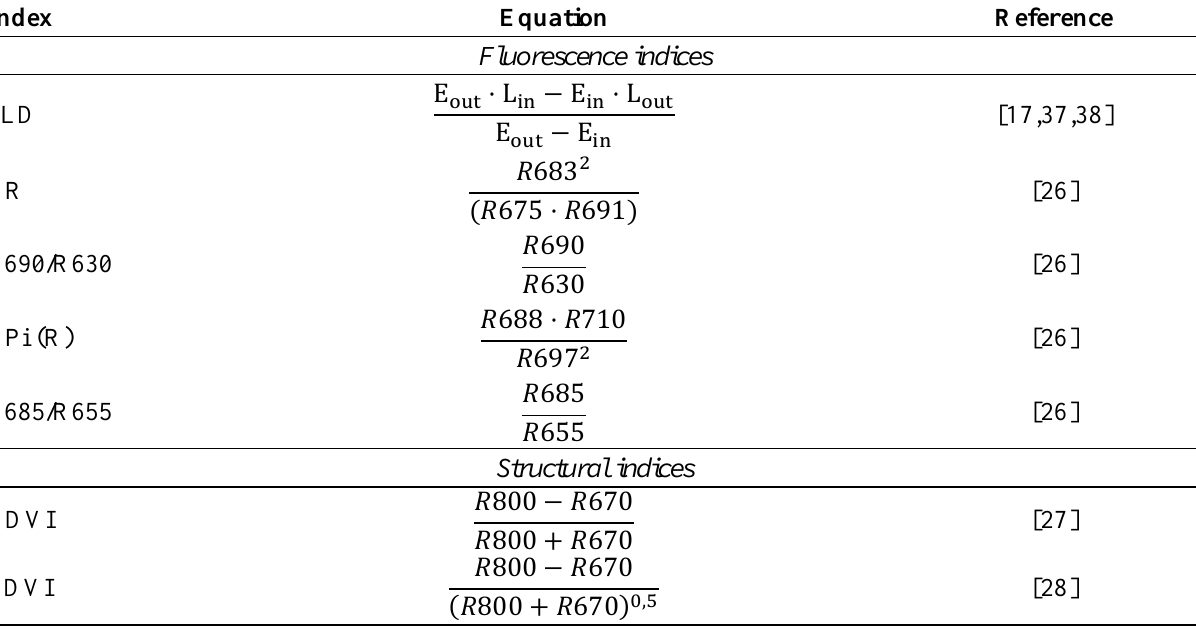
Table 1. Hyperspectral indices used in this